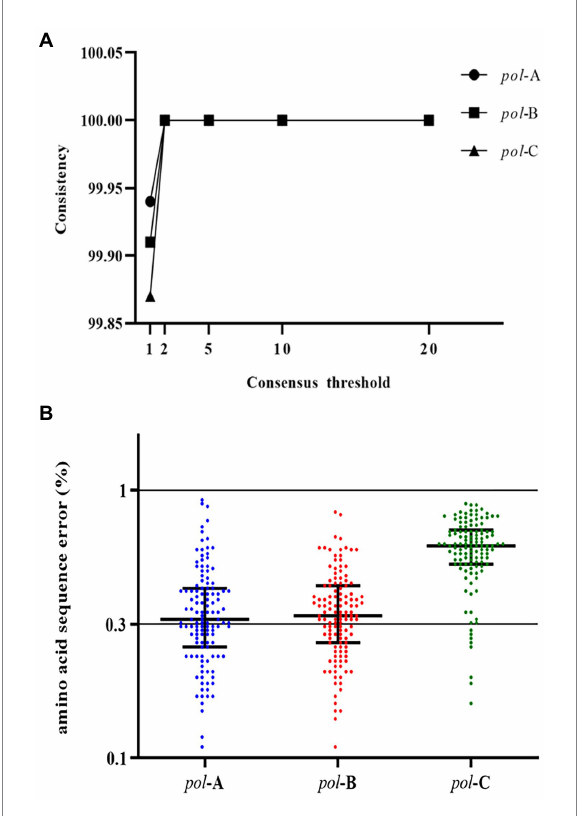
FIGURE 2 (A) Similarity between consensus sequences and SS